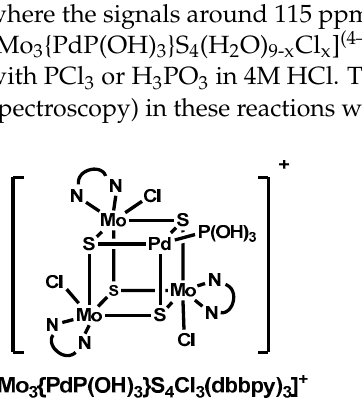
Figure 1. Structure of [Mo 3 {PdP(OH) 3 }S 4 Cl 3 (dbbpy) 3 ] +